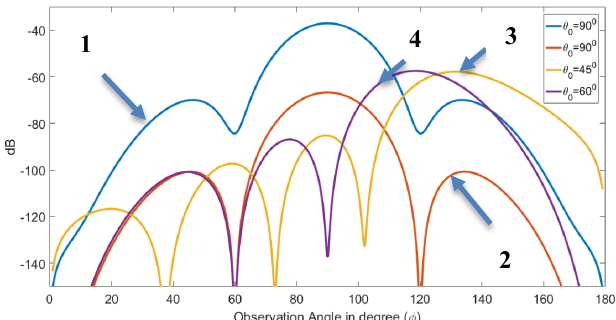
Figure 6: The Amplitude of the Total Electric Field 𝐸Q⃗ AN for 𝑎 = 1 , 𝜖 = 2𝜋 , 𝑥 = 0 and 𝑦 = 6𝜋 F F